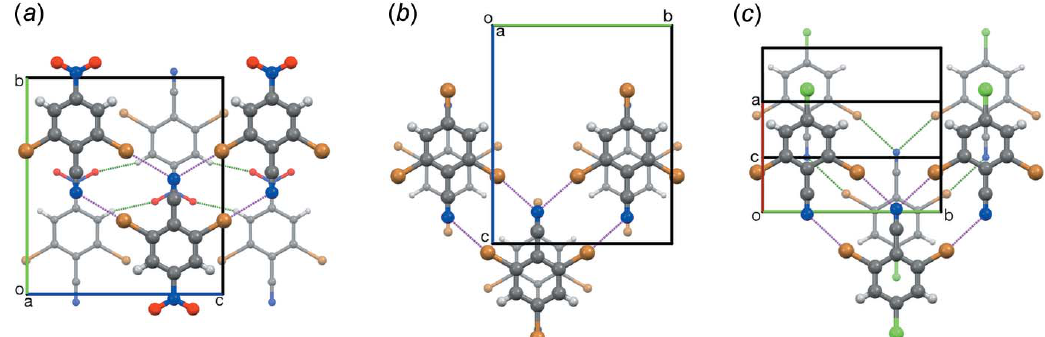
Figure 3 The three stacking modes observed for the given sheet structure: ( a ) glide stacking between adjacent sheets in (I), viewed along [100]; ( b ) centric stacking between alternating sheet pairs in the Z = 8 polytype of (II), viewed along [100]; ( c ) translational stacking between adjacent sheets in (III), viewed along [102]. Dashed magenta lines represent short contacts in the front layer. Molecules in the rear layer are drawn with smaller balls and sticks, lower opacity, and green dashed lines representing short